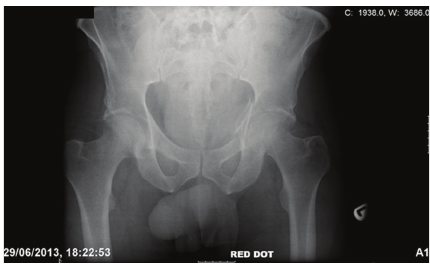
Figure 1: An AP radiograph taken at the time of initial presentation revealing a left acetabular fracture.